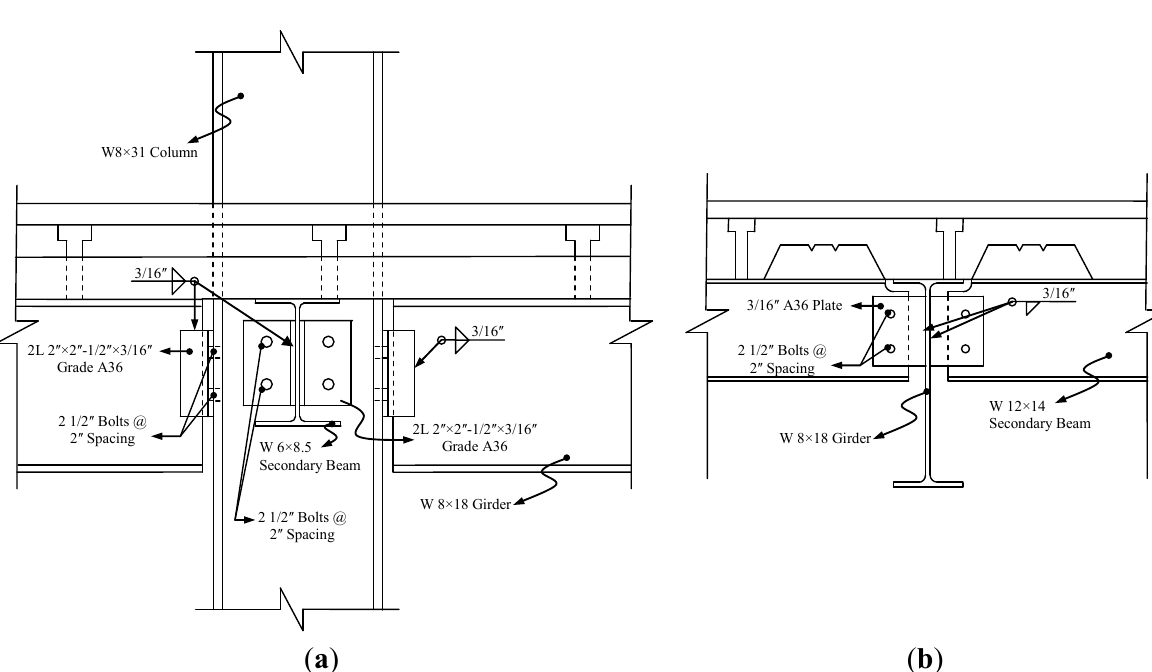
Figure 12. Joint connection details. ( a ) Section A-A; ( b ) Section